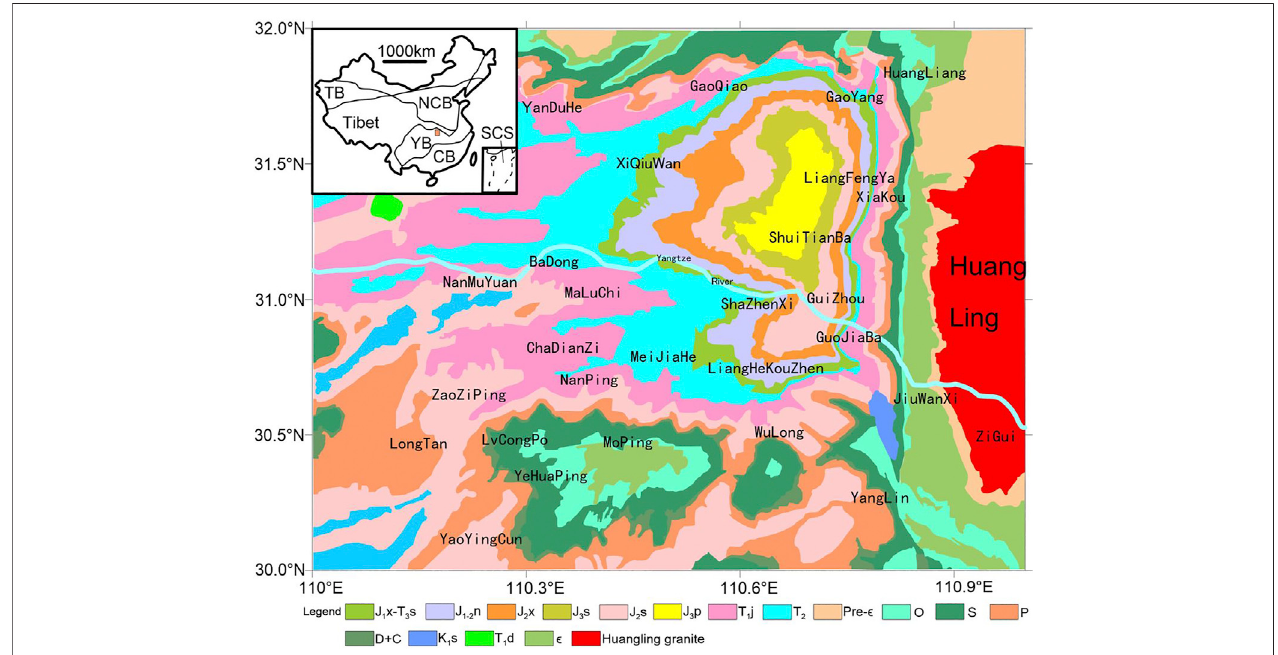
FIGURE 1 | Geographic location and the tectonic map of the Three Gorges reservoir area [from Zhang et al. (2018). J1x-T3s: Lower Jurassic (Xiangxi Formation)- Upper Triassic (Shazhenxi Formation), J1-2n: Middle Jurassic (Niejiashan Formation), J2x: Lower Jurassic (Shaximiao Formation), J3s: Upper Jurassic (Suining Formation), J2s: Upper Jurassic (Shaximiao Formation), J3p: Jurassic (Penglai Town Formation), T1j: Lower Triassic (Jialingjiang Formation), T2: Middle Triassic, Pre- ε : Precambrian, O: Ordovician, S: Siluric, P: Permian, D+C: Devonian-Carboniferous, K1s: Cretaceous (Shimen Formation), T1d: Lower Triassic (Daye Formation), ε : Cambrian].